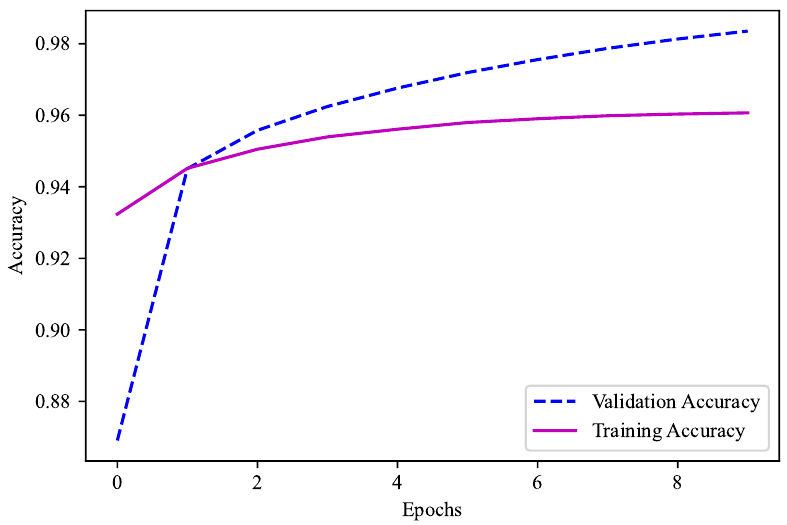
Figure 13. Validation accuracy for model 1 (Temperature